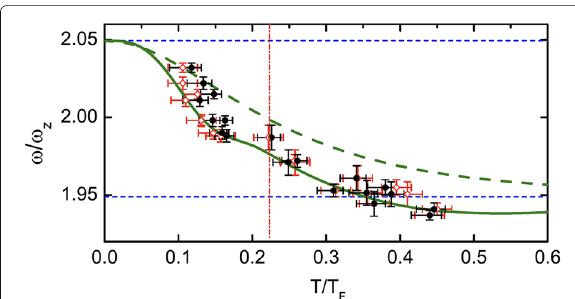
Fig. 8 Comparison between experimental (symbols) and theoretical (green lines) first sound frequencies of the k = 2 mode. The different symbols correspond to different ways of determining temperature. In theoretical calculations, both the equations of state of a unitary Fermi gas (green solid line) and of an ideal Fermi gas (green dashed line) are used. The two thin blue horizontal dashed lines mark the √ 21 / 5) and the classical zero-temperature superfluid limit ( ω/ω z = √ 19 / 5), respectively. The red hydrodynamic limit ( ω/ω z = dash-dotted vertical line indicates the critical temperature in traps T c (cid:3) 0.223 ( 15 ) T F . Adapted from Ref.